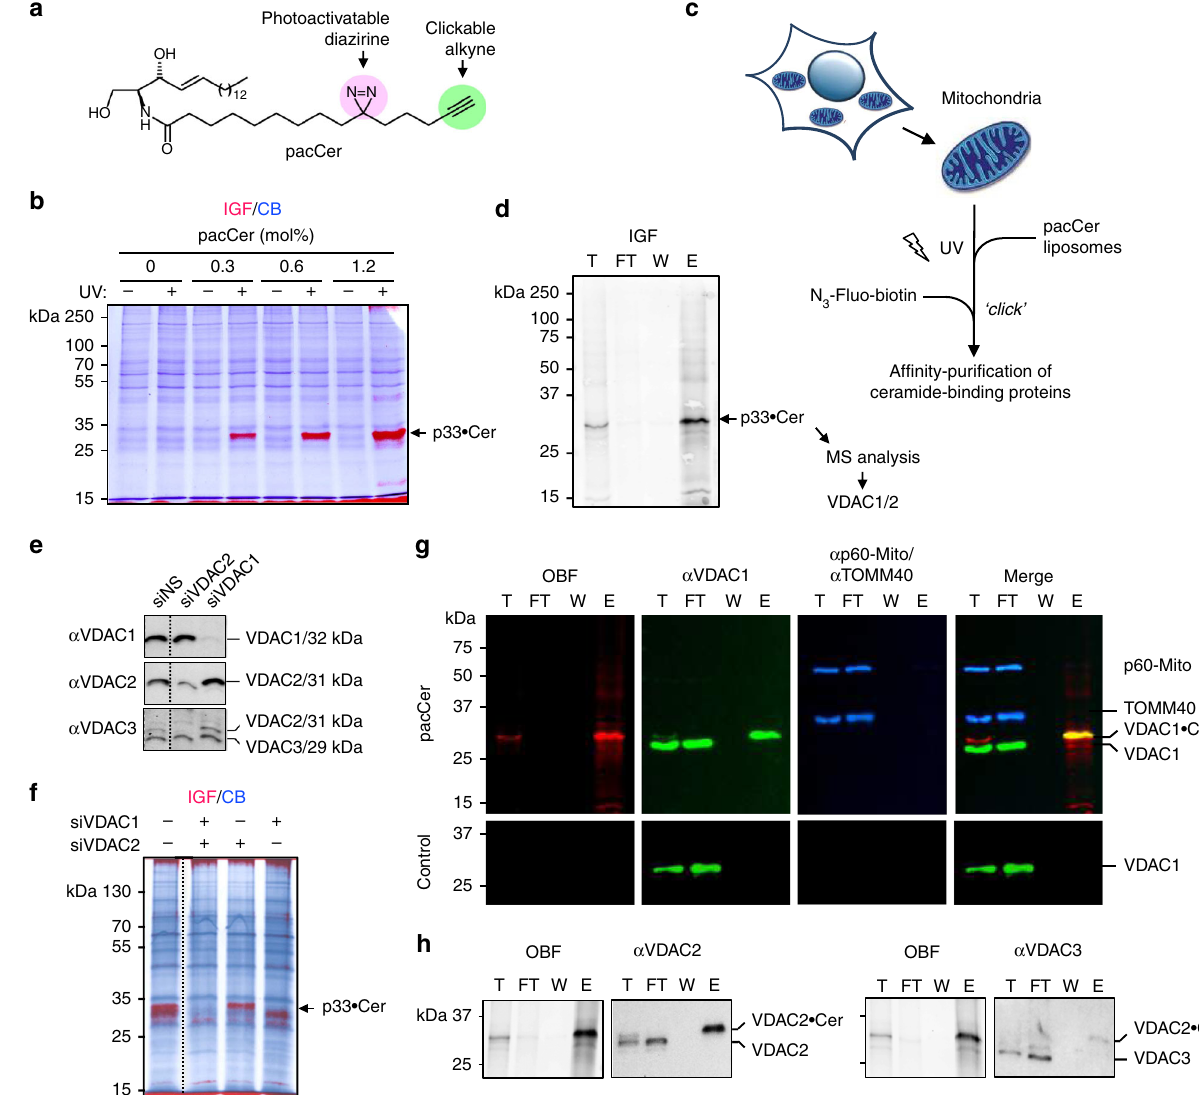
Fig. 1 A chemical screen for mitochondrial ceramide-binding proteins yields VDAC1 and -2. a Structure of the photoactive and clickable C 15 -ceramide analog, pacCer. b Mitochondria isolated from HeLa cells were incubated with liposomes containing increasing amounts of pacCer, UV irradiated, and then click reacted with AF647-N 3 . Samples were processed for SDS-PAGE, subjected to in-gel fl uorescence (IGF, red), and stained with Coomassie blue (CB, blue). p33 (cid:129) Cer denotes a prominently photolabeled protein band of ~33 kDa. c Strategy for the identi fi cation of p33 (cid:129) Cer. d p33 (cid:129) Cer was puri fi ed from pacCer-labeled and TAMRA/biotin click-reacted mitochondria using NeutrAvidin-beads, imaged by IGF, excised from the gel, digested by trypsin, and then identi fi ed by LC-MS/MS. Data from two independent experiments revealed that p33 (cid:129) Cer corresponds to VDAC1 and VDAC2. e Speci fi city of anti-VDAC antibodies was validated by immunoblotting of mitochondria isolated from HeLa cells treated with non-silencing (siNS) or VDAC-targeting siRNAs (siVDAC1, siVDAC2). Note that the anti-VDAC3 antibody cross-reacts with VDAC2. f Mitochondria isolated from siVDAC1/2-treated HeLa cells were photolabeled with pacCer, click-reacted with AF647-N 3 , and subjected to IGF analysis followed by CB staining. g Fractions obtained during af fi nity puri fi cation of p33 (cid:129) Cer were subjected to SDS-PAGE, transferred on nitrocellulose, analyzed by on-blot- fl uorescence (OBF) and probed with antibodies against VDAC1, TOM40, and p60-Mito. h Fractions obtained during af fi nity puri fi cation of p33 (cid:129) Cer were processed as in g and probed with anti-VDAC2 and anti-VDAC3 antibodies. T total mitochondria extract, FT fl ow-through, W wash, E